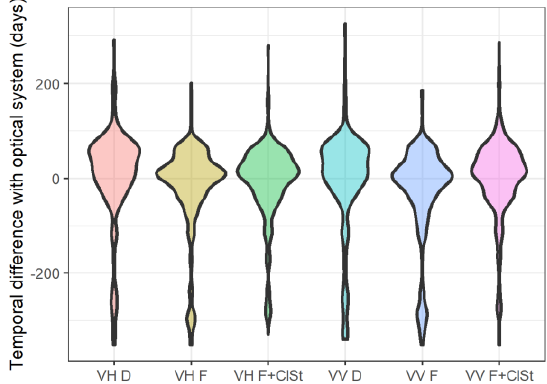
Figure 10: distribution of the difference on detection times (SAR-Optical system), in days. Positive values imply faster SAR detection. D: Original data. F: Filtered data. ClSt: Climate